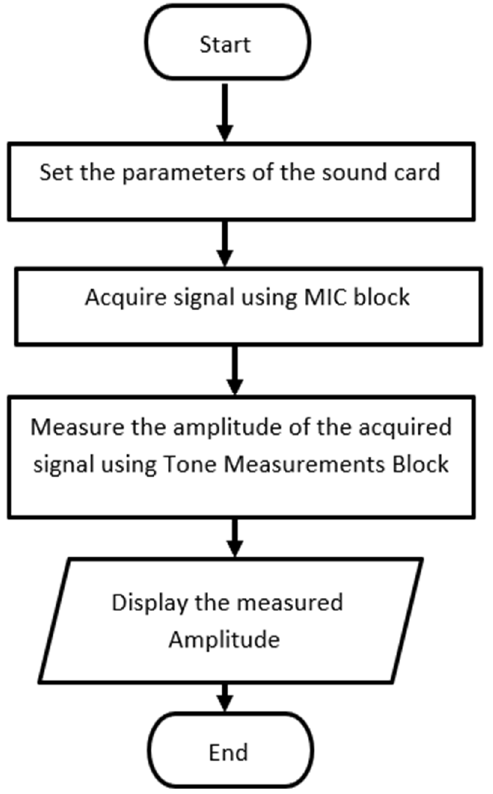
Figure 4. The algorithm for measuring the amplitude of the sound card.